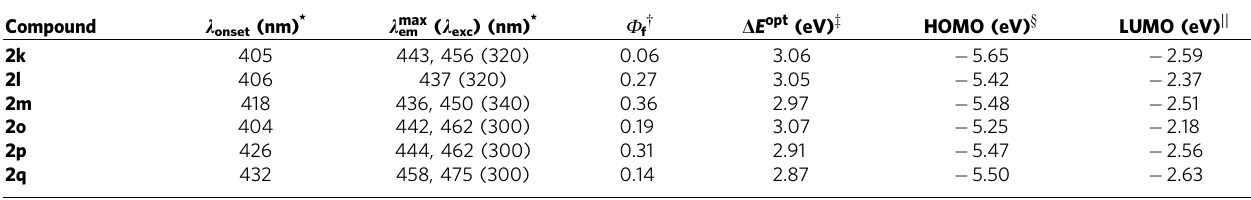
Figure 4 | Construction of phenanthrene motif. The reaction with nonfluorenyl substrate 1r is able to produce the corresponding 9,10- diphenylphenanthrene 2r under the standard